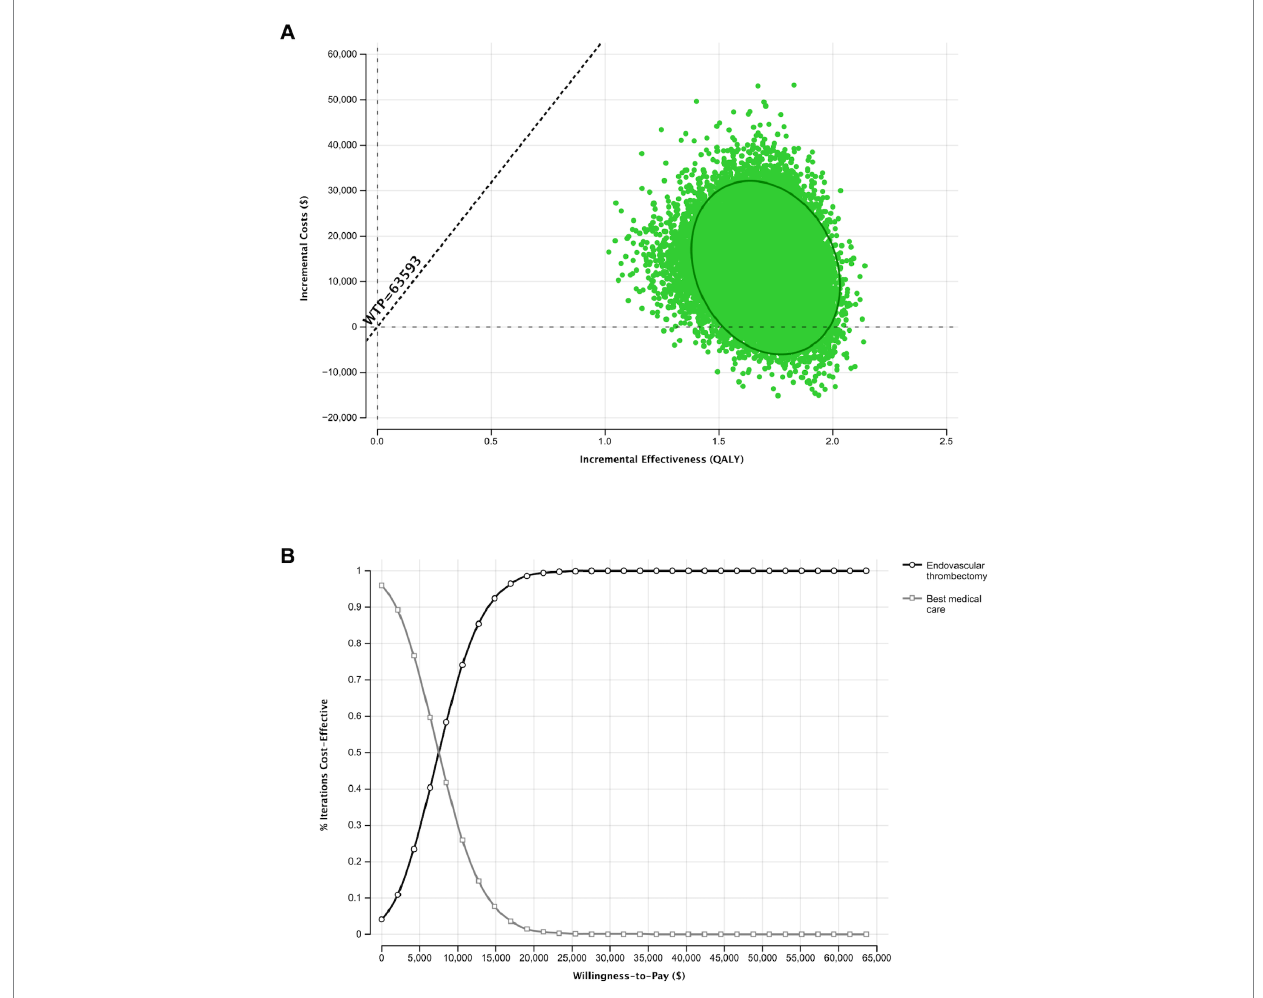
FIGURE 2 Probabilistic sensitivity analysis and Monte Carlo Simulation with 30,000 iterations for the base-case scenario. (A) Results of 30,000 simulations of incremental costs and incremental outcomes of endovascular thrombectomy in comparison to best medical care. (B) The Acceptability curve shows the cost-effectiveness of both therapeutic depending on an increasing willingness to